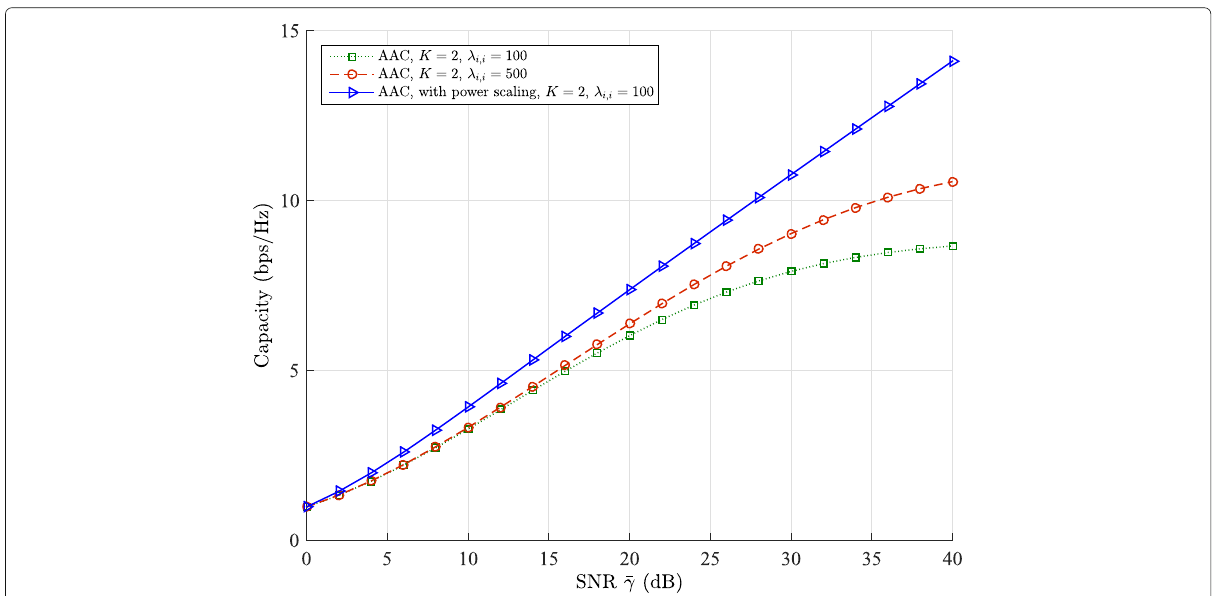
Fig. 5 Ergodic capacity under AAC with K = 2 and different values of λ i ,